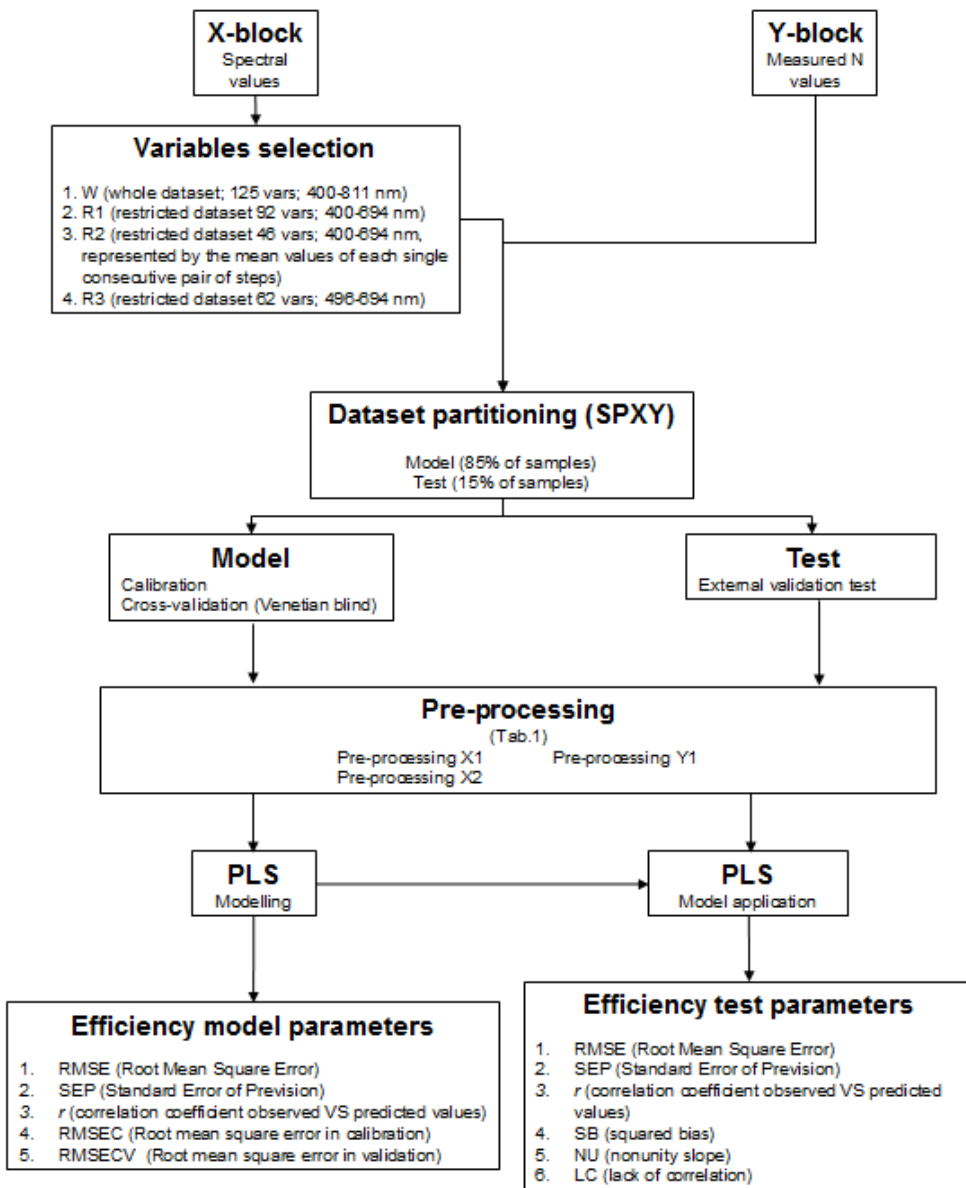
Figure 1. Spectral data chemometric analysis